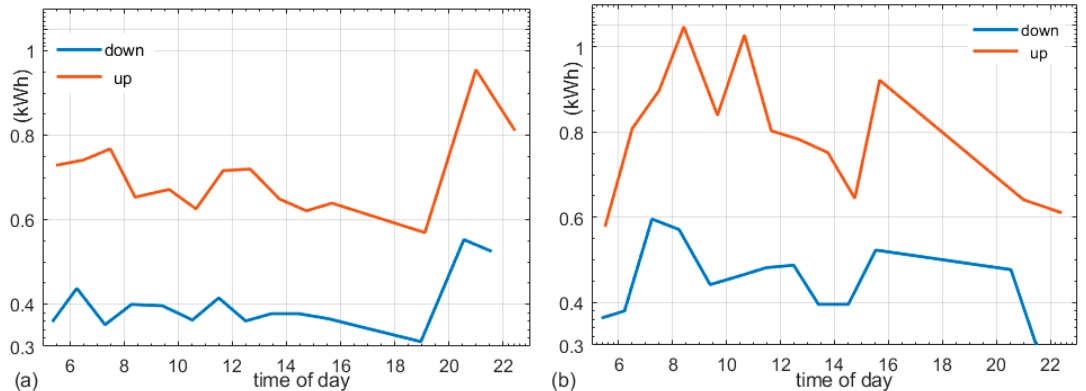
Figure 4. Mean energy consumption for upward and downward bus trips with a small elevation difference but longer upward distance in( a ) winter and( b ) summer.